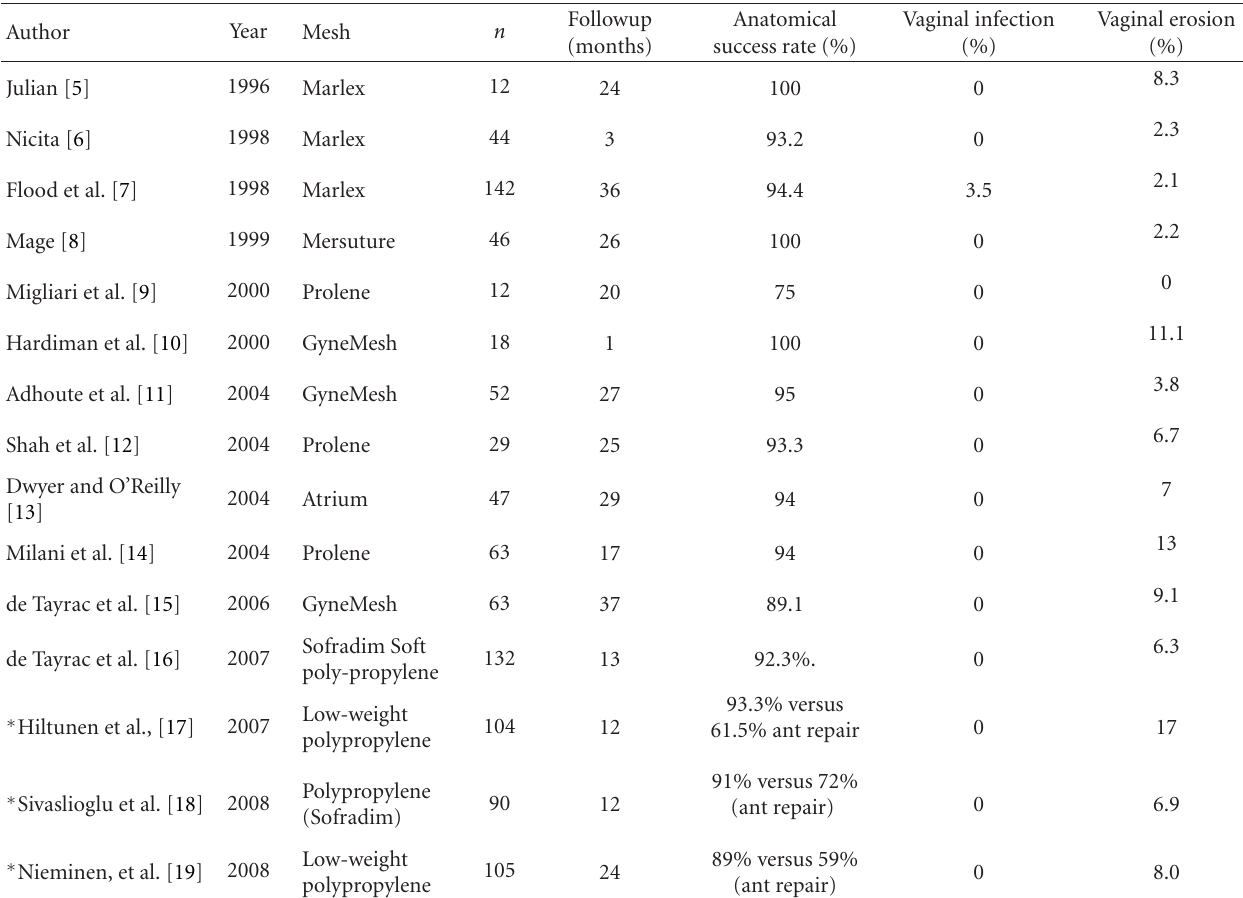
Table 4: Review of literature of mesh use in cystocele